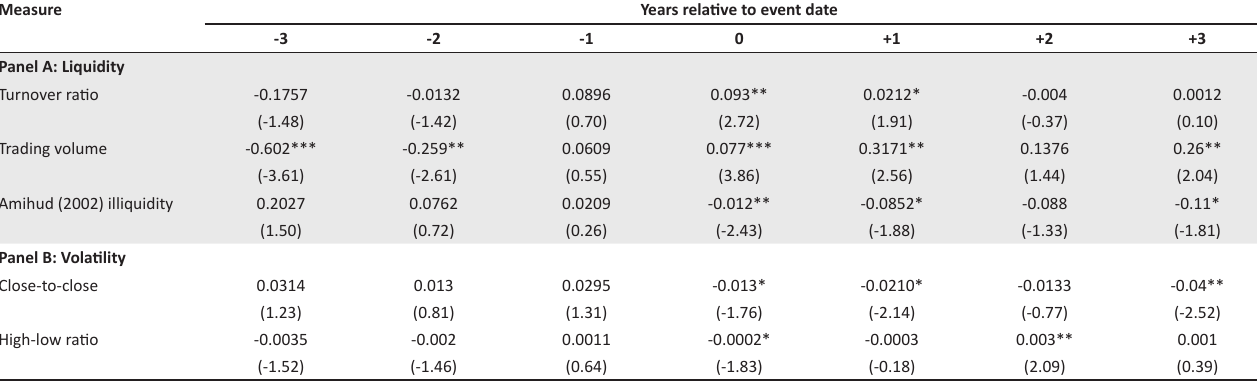
TABLE 6: Evolution of domestic stock liquidity and volatility around event date. Measure Years relative to event